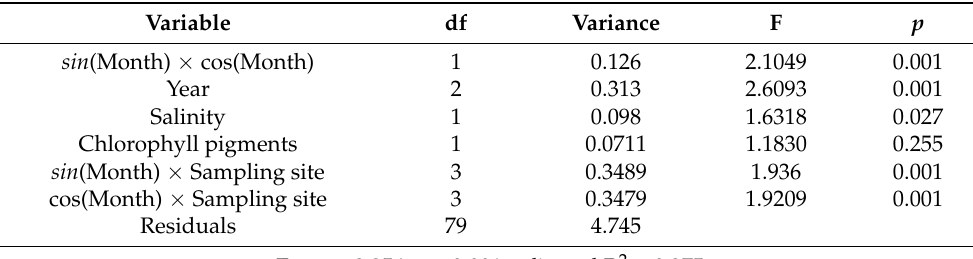
cos(Month) × Sampling